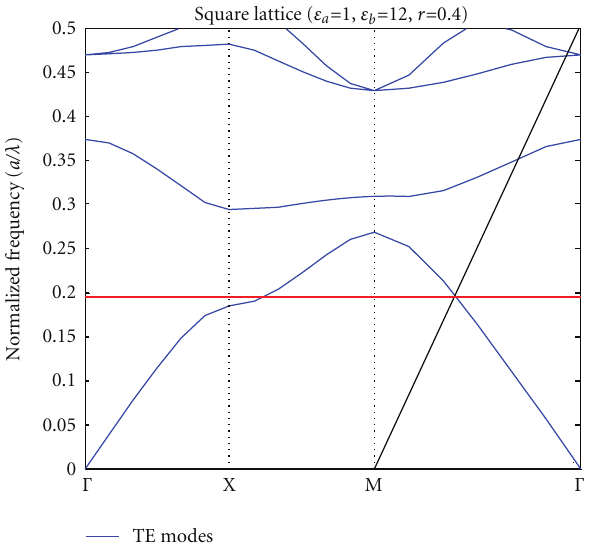
Figure 1: Band curves of square lattice for TE polarization. The 2D PhC is made of air holes of radius r = 0 . 4 a (where a is the lattice constant) drilled in a silicon host substrate with ε = 12. The light line shifted to M point is shown in black. The red line indicates the frequency range of negative refraction.